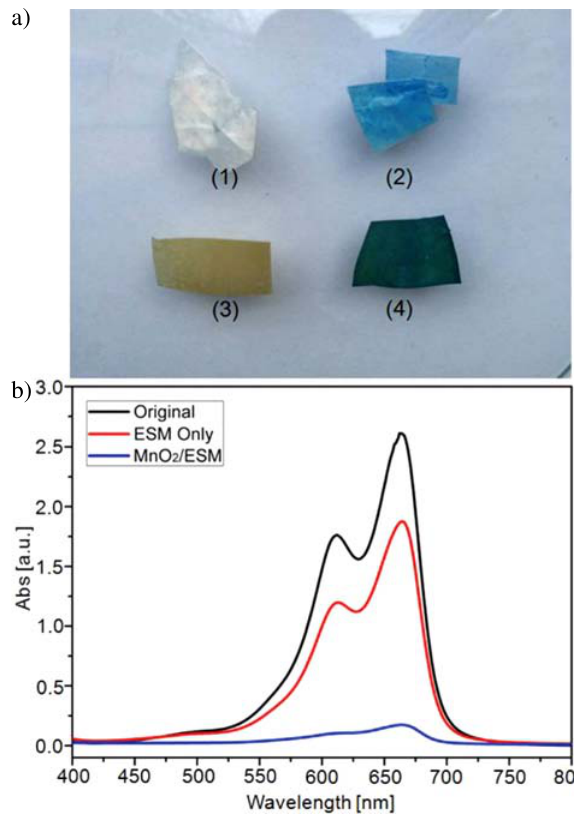
Figure 4. (a) Photographs of ESM and MnO /ESM before and after 2 adsorption of MB [ (1) ESM only; (2) ESM only after adsorption of MB; (3) MnO /ESM SMPs; (4) MnO /ESM after adsorption of 2 2 MB. ] . (b) The UV-vis absorption spectra of MB before and after adsorption by ESM only and MnO SMPs. 2 2